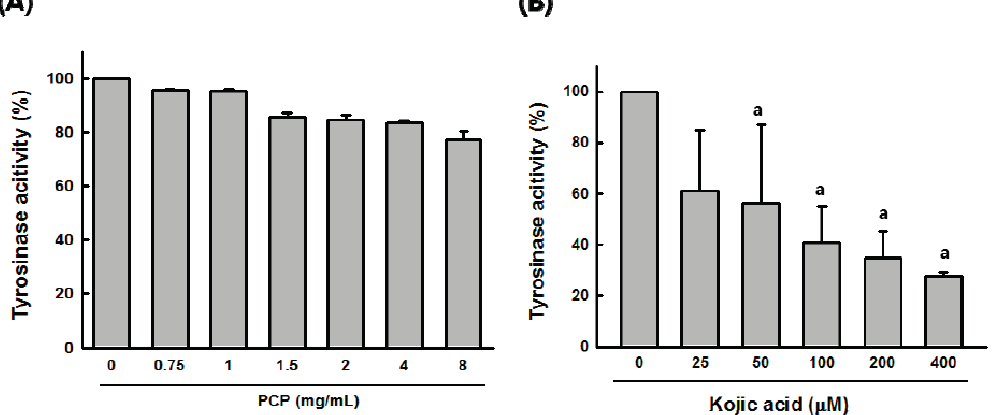
Figure 3. Inhibitory effects of PCP on melanogenesis. ( A ) The effect of PCP on mushroom tyrosinase activity was determined at concentrations of 0.75, 1, 1.5, 2, 4, and 8 mg/mL; ( B ) the effect of Kojic acid on mushroom tyrosinase activity was observed at concentrations of 25, 50, 100, 200, and 400 μ M. Values are expressed as the means ± SD from three independent experiments. PCP, pomegranate concentrate powder. a p < 0.05 compared with the control (veh) using the LSD